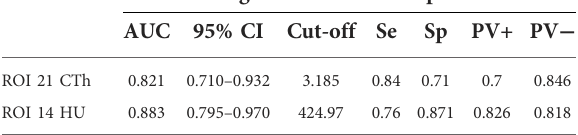
ROI, region of interest; CTh, cortical bone thickness; HU, Houns fi eld unit; AUC, area under the curve; Se, sensitivity; Sp, speci fi city; PV+, positive predictive value; PV − , negative predictive